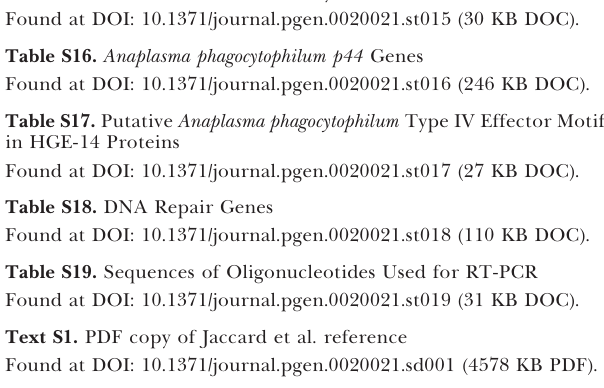
Table S6. Ortholog Clusters Present in Wolbachia pipientis, Anaplasma phagocytophilum, and Ehrlichia chaffeensis, but Not in Neorickettsia sennetsu Table S7. Ortholog Clusters Present in Rickettsia prowazekii and Wolbachia pipientis, but Not in Neorickettsia sennetsu, Anaplasma Table S8. Ortholog Clusters Present in Anaplasma phagocytophilum and Ehrlichia chaffeensis, but Not in Rickettsia prowazekii, Wolbachia pipientis, Table S9. Individual Genes (Based on Ortholog Cluster Analysis) Present in Anaplasma phagocytophilum, but Not in Ehrlichia chaffeensis, Table S10. Individual Genes (Based on Ortholog Cluster Analysis) Present in Ehrlichia chaffeensis but Not in Anaplasma phagocytophilum, Table S11. Individual Genes (Based on Ortholog Cluster Analysis) Present in Neorickettsia sennetsu but Not in Anaplasma phagocytophilum, Table S12. Ortholog Clusters Present Only in Anaplasma phagocytophi- lum and Anaplasma marginale Table S13. Ortholog Clusters Present Only in Ehrlichia chaffeensis, Ehrlichia ruminantium Welgevonden, and Ehrlichia ruminantium Gardel Found at DOI: 10.1371/journal.pgen.0020021.st013 (82 KB DOC). Table S14. Ortholog Clusters That Are Absent in All of the Tick-, Flea-, and Louse-Borne Rickettsiales, but Are Present in Wolbachia Table S15. Ortholog Clusters Present in All the Pathogenic Rickettsiales but None of the Endosymbionts Table S16. Anaplasma phagocytophilum p44 Genes Table S17. Putative Anaplasma phagocytophilum Type IV Effector Motifs in HGE-14 Proteins Table S18. DNA Repair Genes Table S19. Sequences of Oligonucleotides Used for